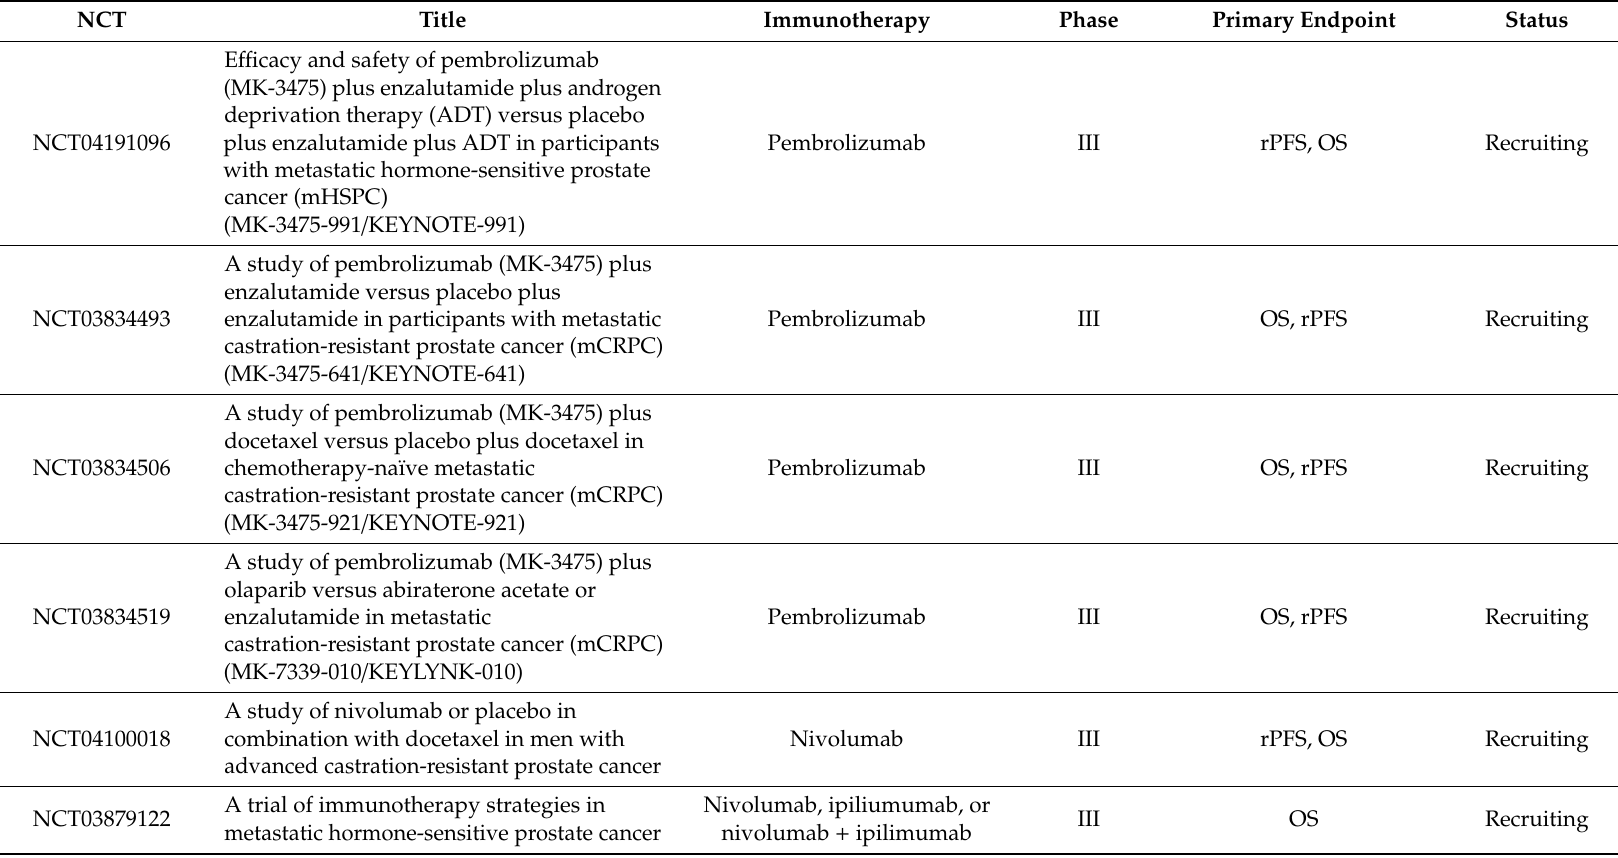
Table 1. Ongoing Phase III Clinical Trials Evaluating checkpoint inhibitors (CPIs) in Metastatic Prostate